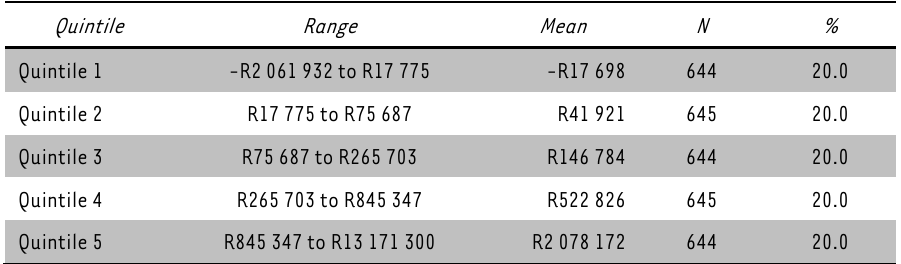
TABLE 3: Household net equity quintile Quintile